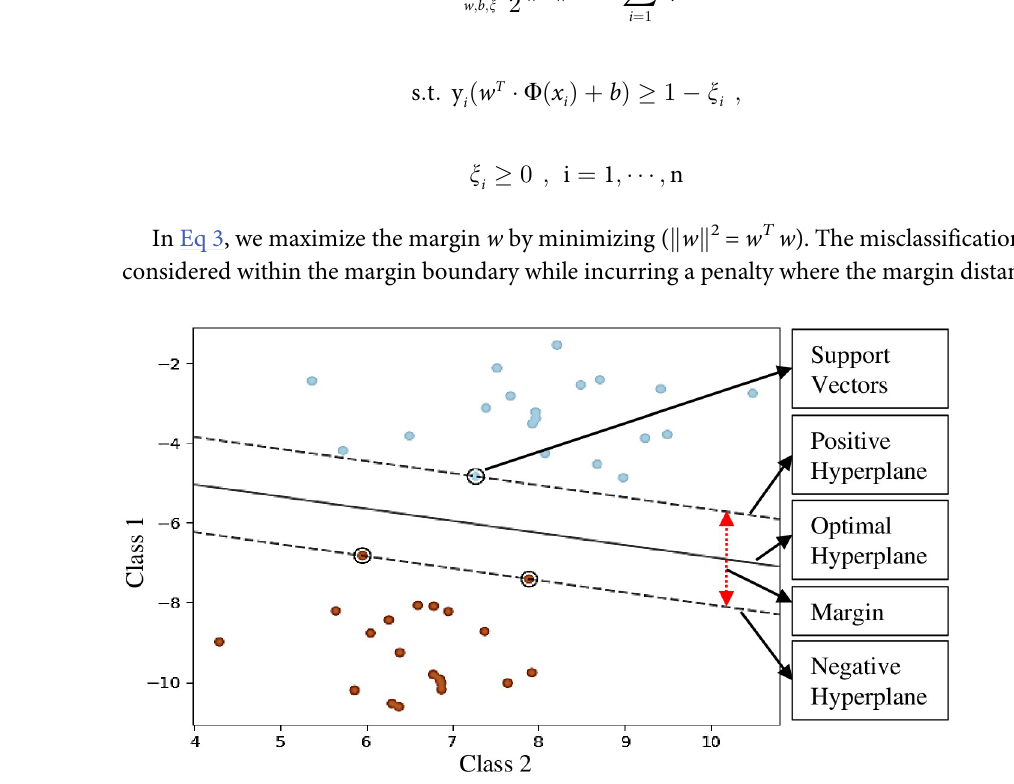
Fig 8. Clustering processes of Support Vector Classifier